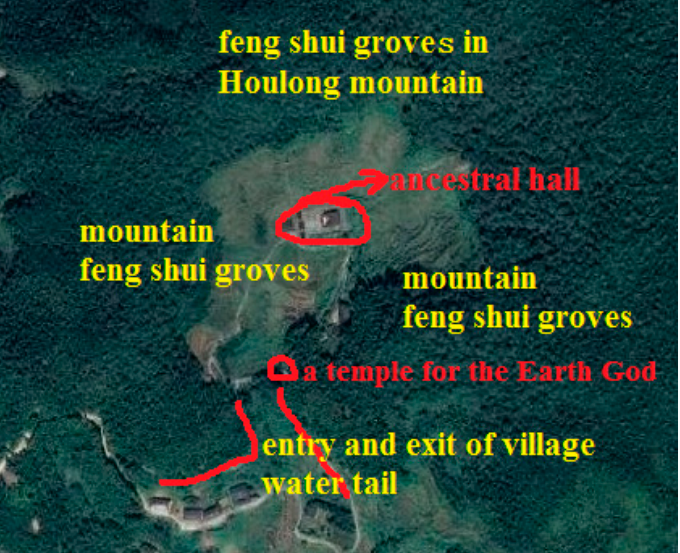
Figure A1. Geographical features of Lingtou village. Note: village houses surround the ancestral hall in ancient times. Vacant land in the figure is farmland.